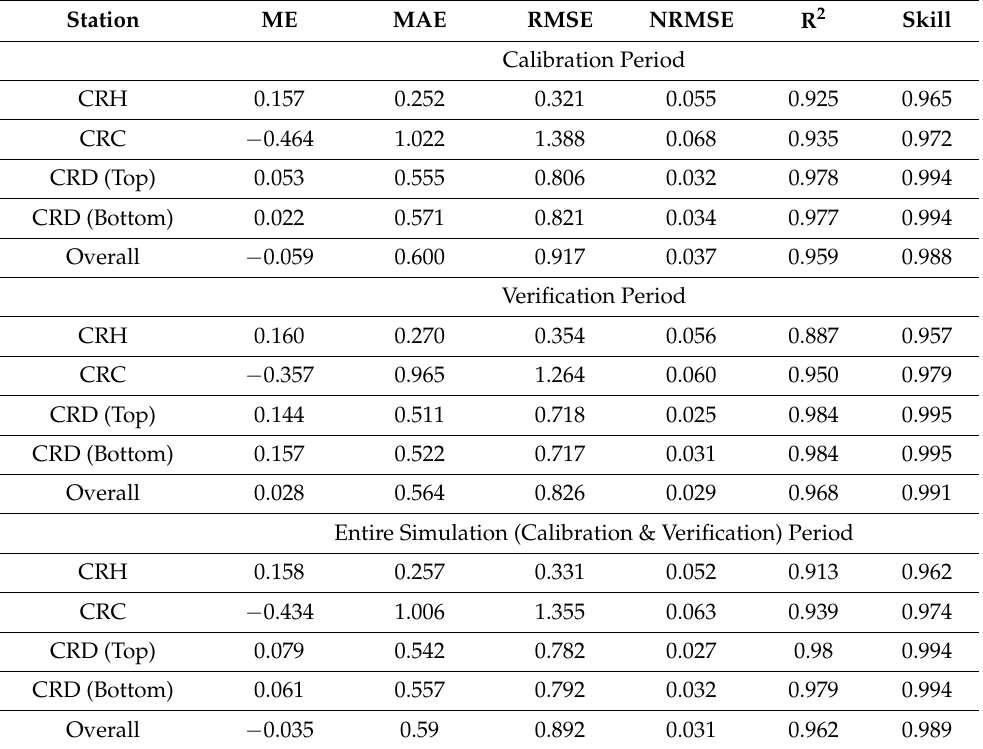
Table 4. MEs, MAEs, RMSEs, NRMSEs, R 2 values, and skills for simulated temperatures ( ◦ C) in comparison with real-time field data measured at the CRH, CRC, and CRD stations during the calibration period, the verification period, and the entire simulation period.